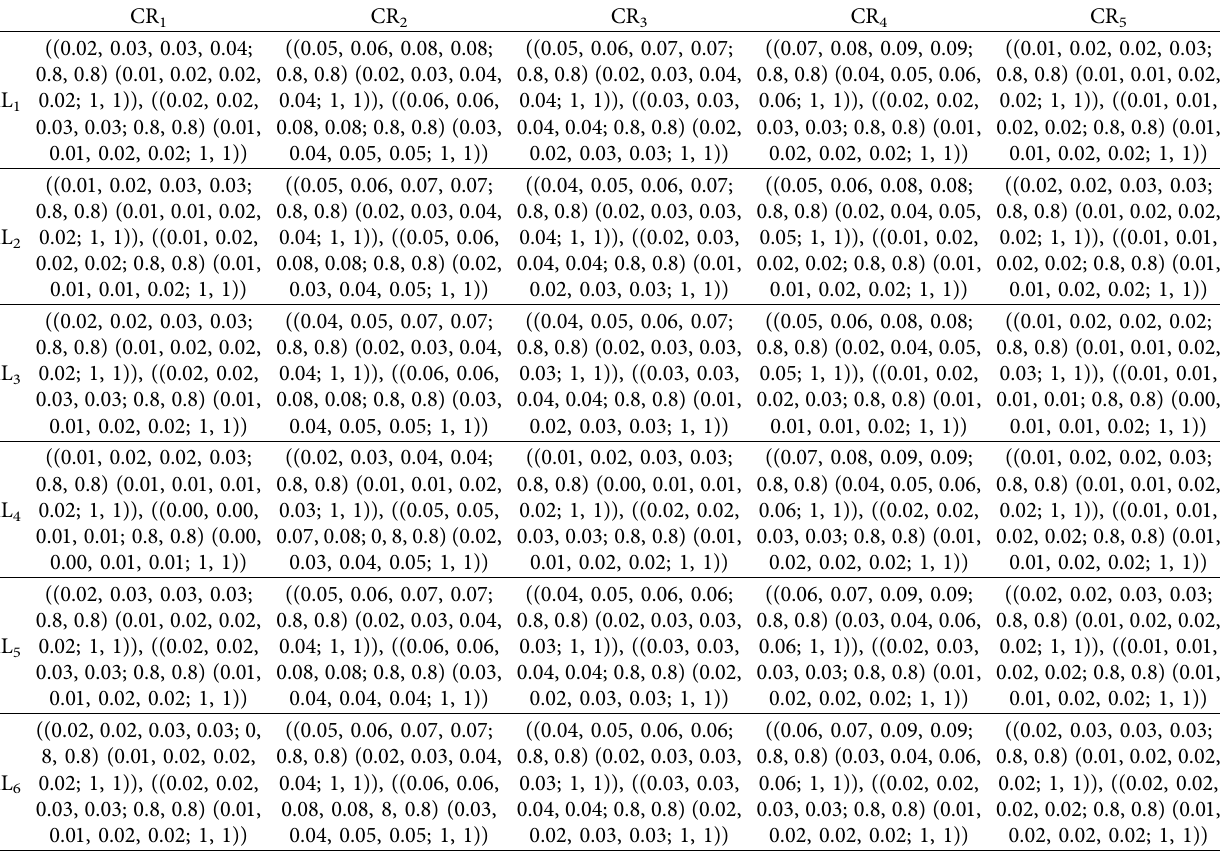
Table 9: Weight of decision matrix.